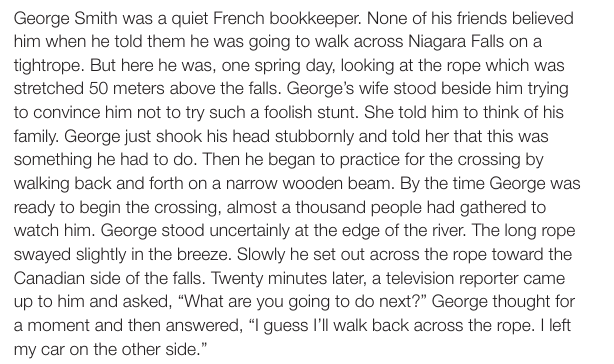
TABLE 1 | Story used for the reading comprehension task.